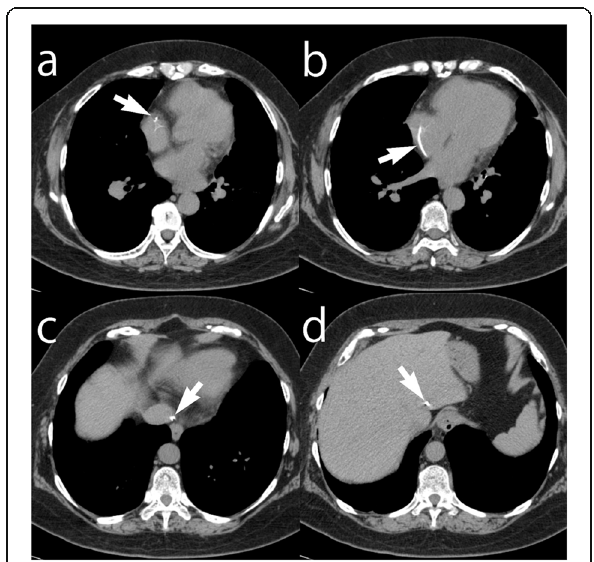
Fig. 1 Non-contrast-enhanced CT images in a 61-year-old female patient with colon cancer show a dislodged central venous catheter fragment with inaccessible ends. The catheter was implanted 16years ago to treat breast cancer and its fragment was migrated in the right atrium at least 3.5years ago. a The upper end of the catheter fragment is located in the right atrial appendage. b It runs through the right atrium and c inferior vena cava until d its lower end strayed into the left hepatic vein